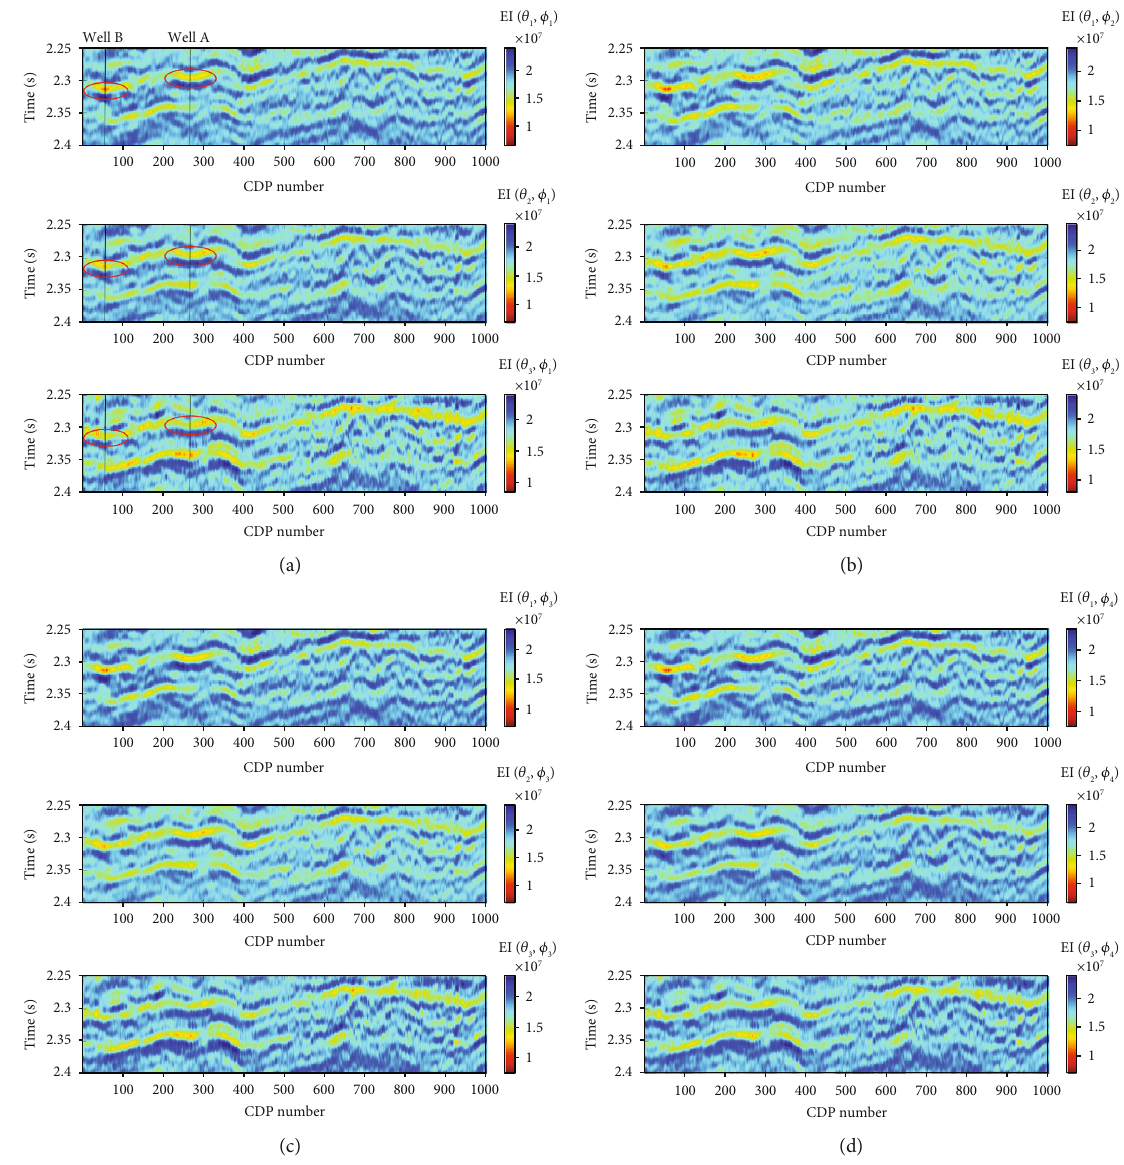
Figure 9: Estimated azimuthal attenuation EI pro fi les with three angles of incidence (5 ° , 15 ° , and 25 ° , respectively), where the average azimuth angles are 22.5 ° (a), 67.5 ° (b), 112.5 ° (c), and 157.5 °